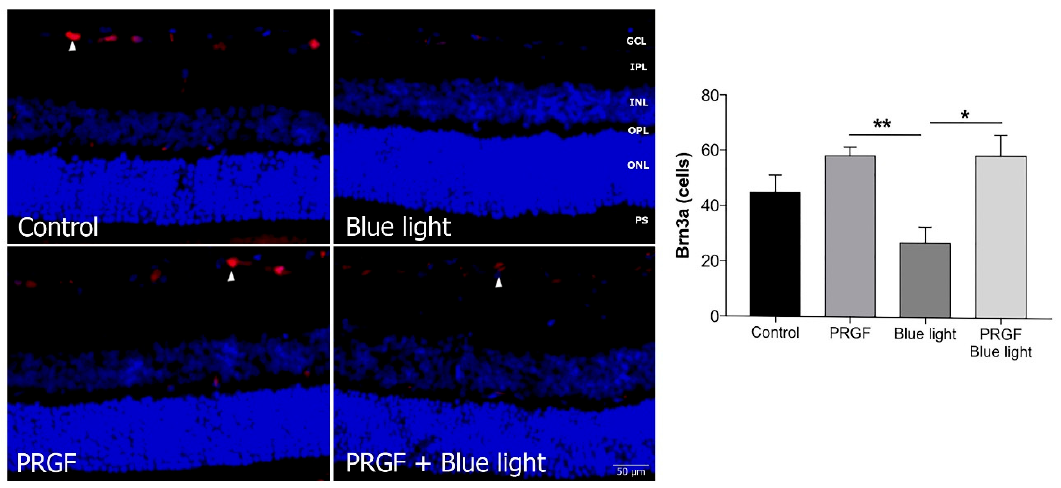
Figure 4. Immunofluorescence for Brn3a (red) and DAPI (blue) in transversal sections of retinas ( n = 4). The results showed that the expression of Brn3a was interrupted by blue light compared to control and PRGF treatment conditions. However, when blue light was combined with PRGF, its expression recovered. Arrowheads show positive cells for Brn3a. Statistical analysis: One-way ANOVA, Sidak’s multiple comparison test ( n = 3), * p < 0.05 and ** p < 0.05. Scale = 50 µm.